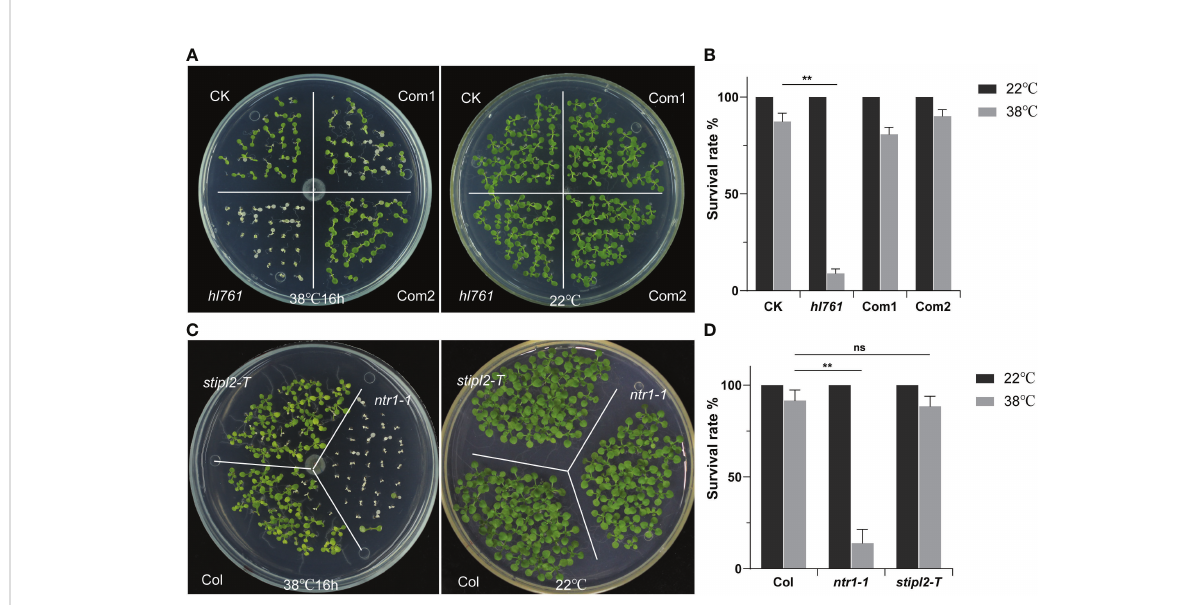
FIGURE 3 NTR1 is required for plant heat stress tolerance. (A) Heat stress phenotype of CK, hl761 , and two complemental lines. Left, seedlings were heat treated at 38°C for 16 h and then recovered at 22°C. Right, the same time duration of seedlings is kept at 22°C. CK, background line for hl761 . (B) The survival rate of heat-treated CK, hl761 , and two complemental lines. Error bars indicate the SD of three biological replicates. Asterisks indicate statistically signi fi cant differences (**p < 0.01 in Student ’ s t-test). (C) Heat stress phenotype of T-DNA insertion mutants of NTR1 and its homolog STIPL2 . Left, seedlings were heat treated at 38°C for 16 h and then recovered at 22°C. Right, the same time duration of seedlings is kept at 22°C. (D) The survival rate of heat-treated Col and T-DNA insertion mutants of NTR1 and STIPL2 . Error bars indicate the SD of three biological replicates. Asterisks indicate statistically signi fi cant differences (ns, no signi fi cance; **p < 0.01 in Student ’ s